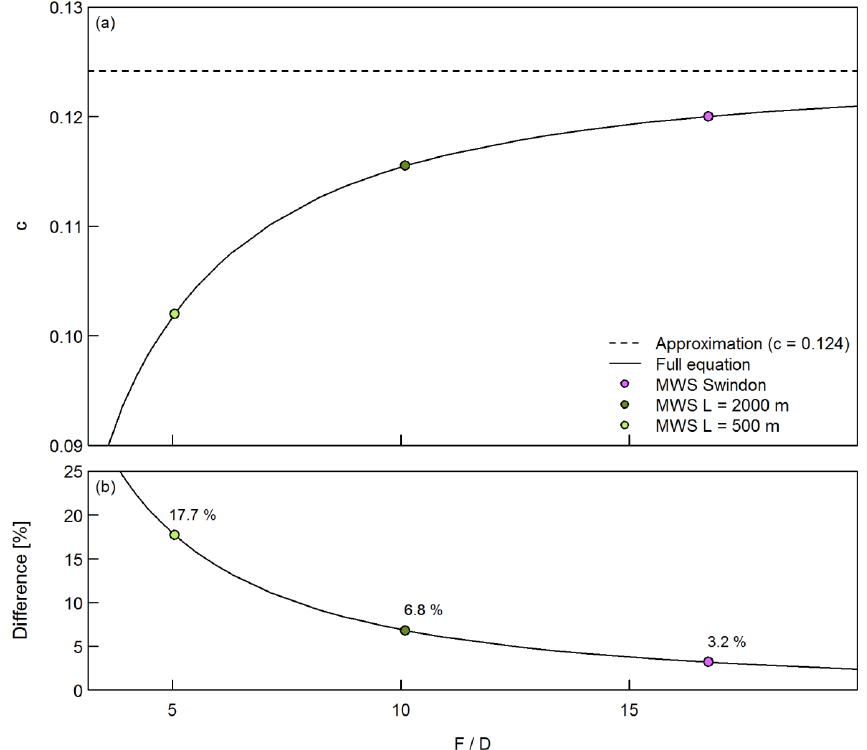
Figure A1. (a) Value of the multiplier, c , in Eq. (A4) when calculated using the full equation (Eq. A2) as a function of the ratio of Fresnel zone F to aperture diameter D and (b) percentage difference from the small aperture approximation (Eq. A3). Some example experimental setups are selected for the CEH-RAL